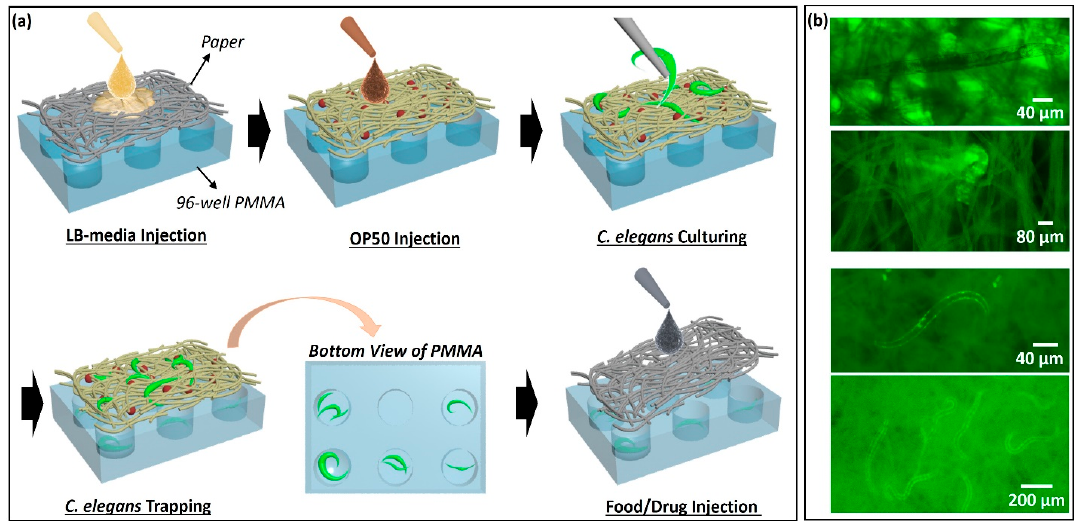
Figure 2. ( a ) Fabrication procedures, ( b ) immobilized C. elegans in paper substrates.